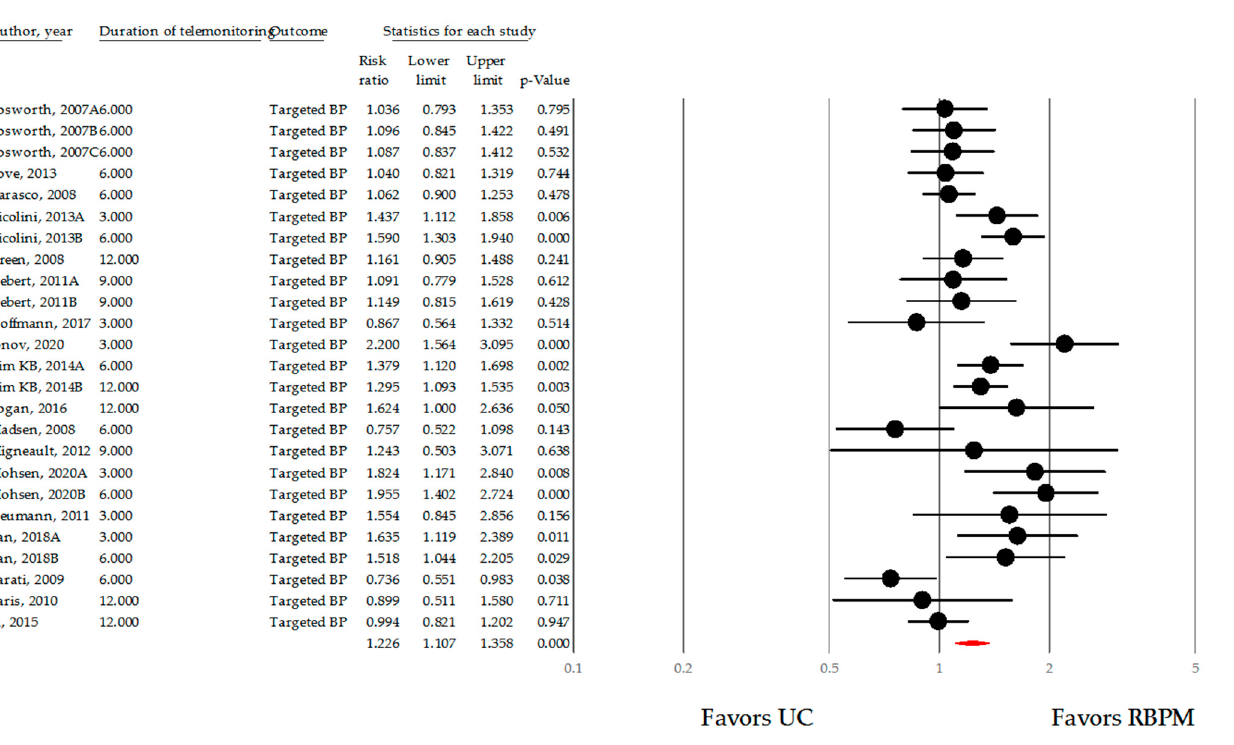
Figure 3. A funnel plot of standardized mean difference in diastolic blood pressure. Note: summary effect size ( ◇ ), sum- mary effect size of imputed studies ( ◆ ), individual study ( ○